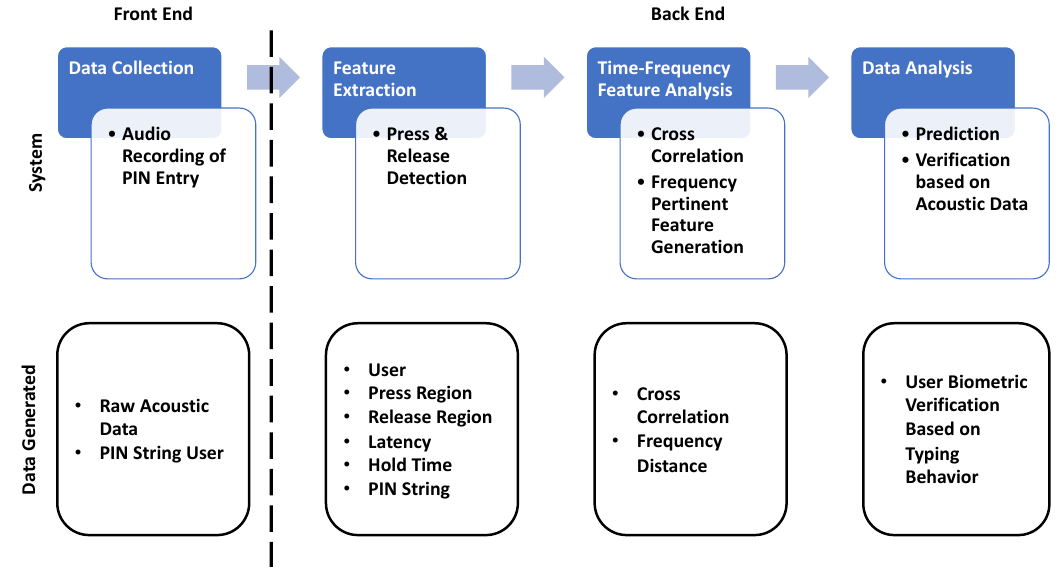
Figure 2. Experimental workflow